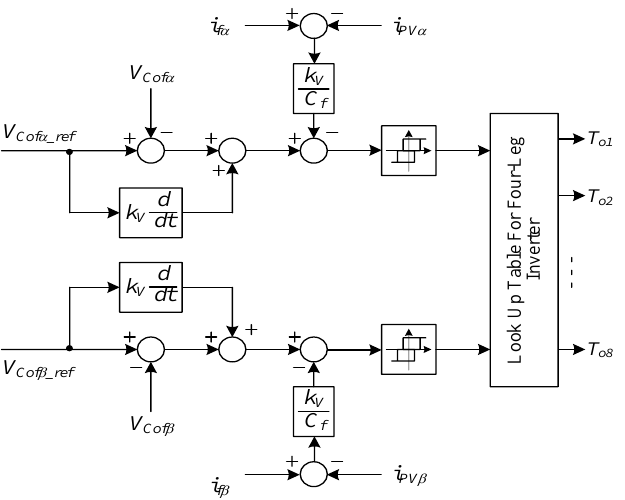
Figure 5. Diagram of the current control scheme for the four-leg inverter.